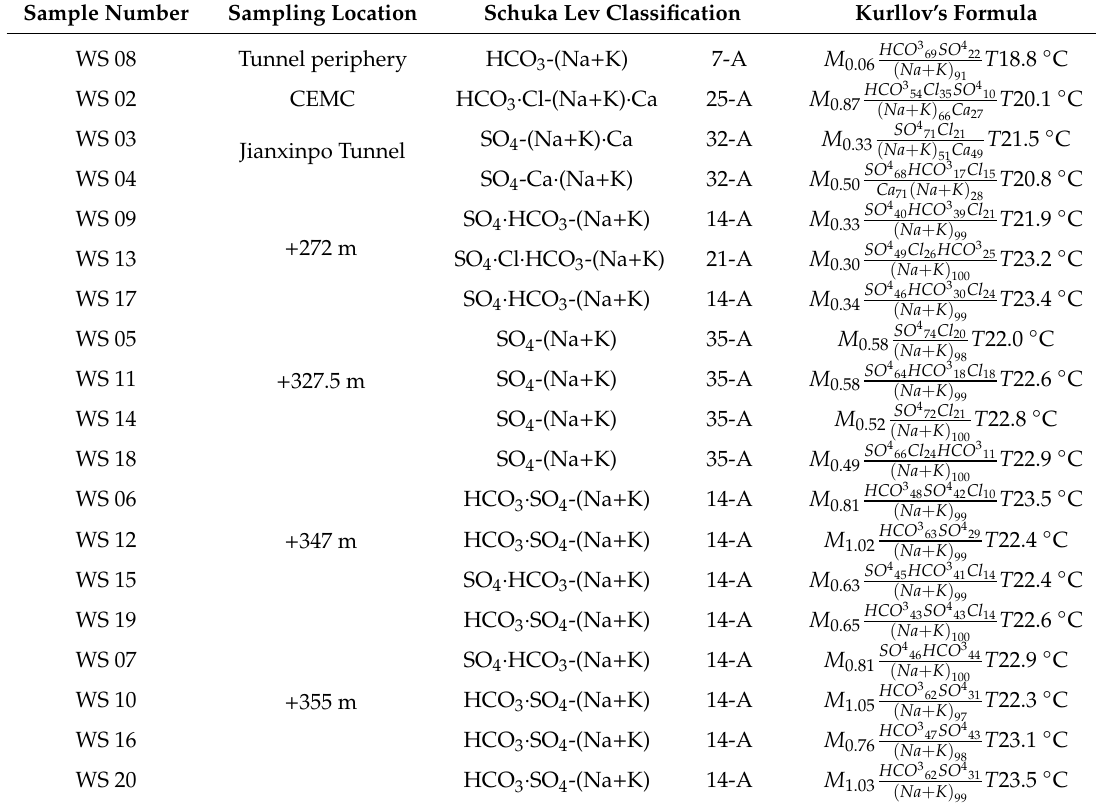
Table 4. Classifications of traditional hydrochemical analysis